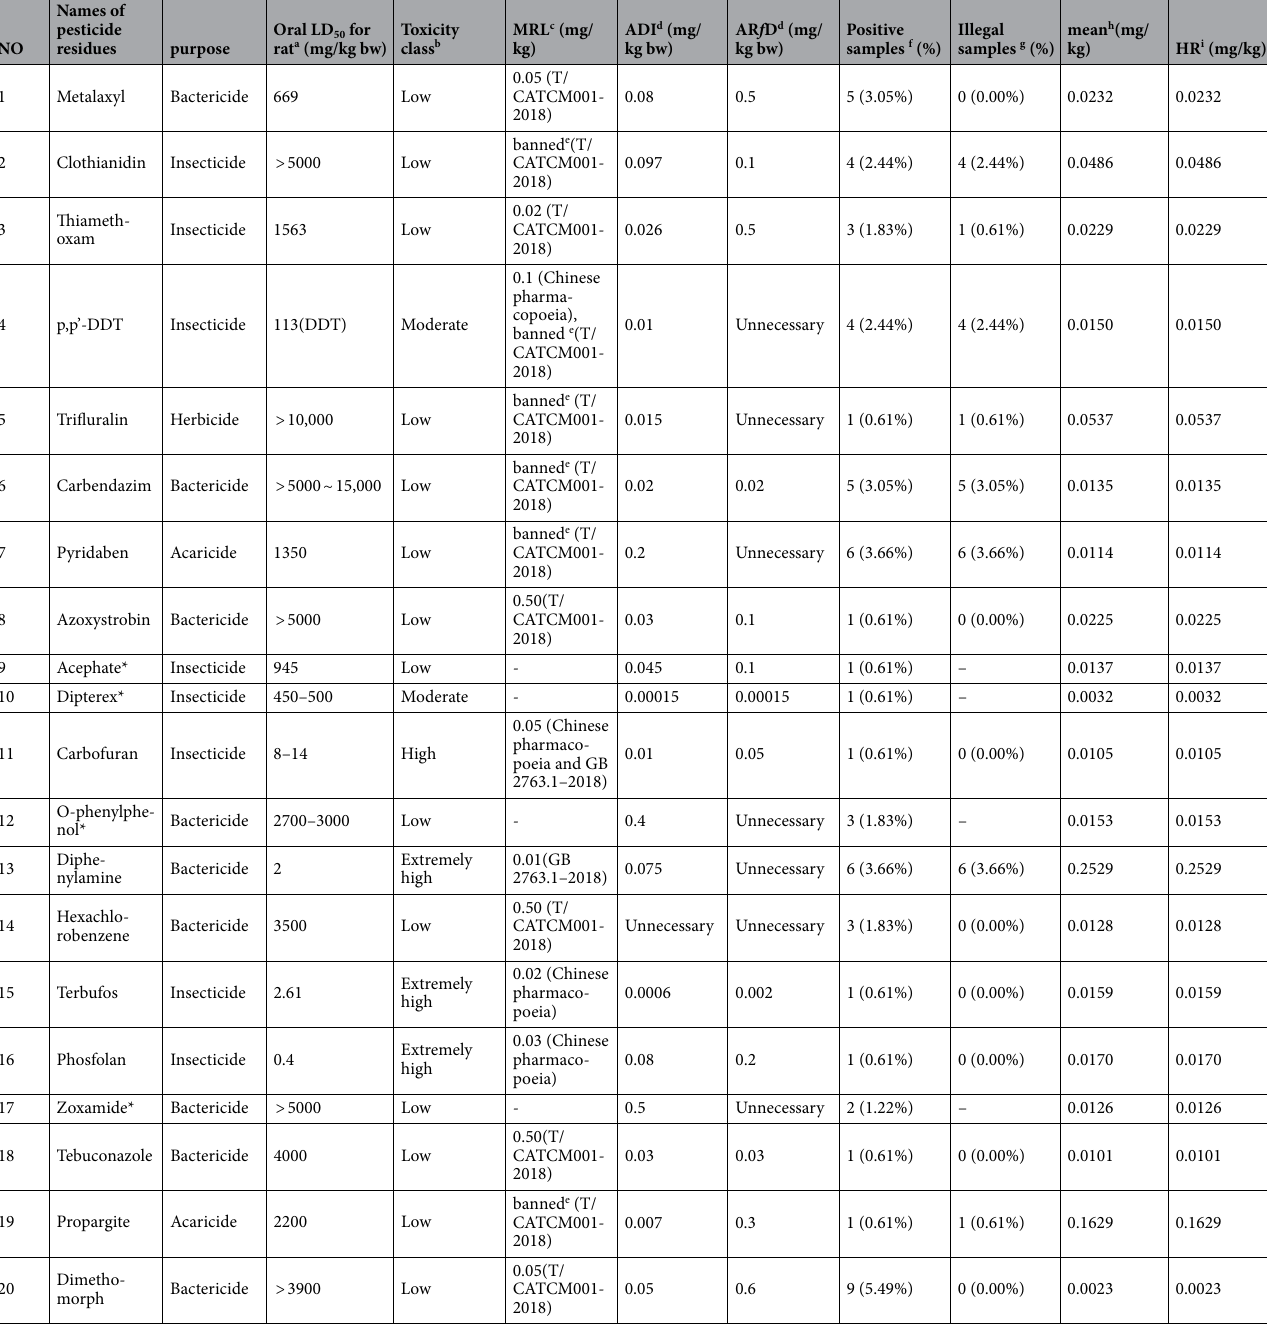
Table 2. Information and test results of pesticide residues detected. a LD 50 data were taken from the China Pesticide Information Network (http:// www. china pesti cide. gov. cn/). b Toxicity class was according to the Chinese national standard GB 15670-1995. c Maximum residue limits (MRLs) were referred to the Chinese national standard GB 2763.1–2018 for food, the Chinese pharmacopoeia for traditional Chinese medicine (TCM) and Group standard T/CATCM001-2018 for ginseng. d Acceptable daily intakes (ADIs) and acute reference doses (ARfDs) were taken from the EU pesticides database (http:// ec. europa. eu/ food/ plant/ pesti cides/ eu- pesti cides datab ase). e “Banned” indicates that the pesticide is not be detected on traditional Chinese medicine (TCM) in China according to the Chinese national standard GB 2763.1–2018, the Chinese pharmacopoeia and Group standard T/CATCM001-2018. f Samples with pesticide residue higher than the LOQ. g Samples with pesticide residue higher than the MRLs or containing banned pesticides. h “Mean” is the mean residue. i “HR” is the maximum residue. *Indicates that no maximum limit is